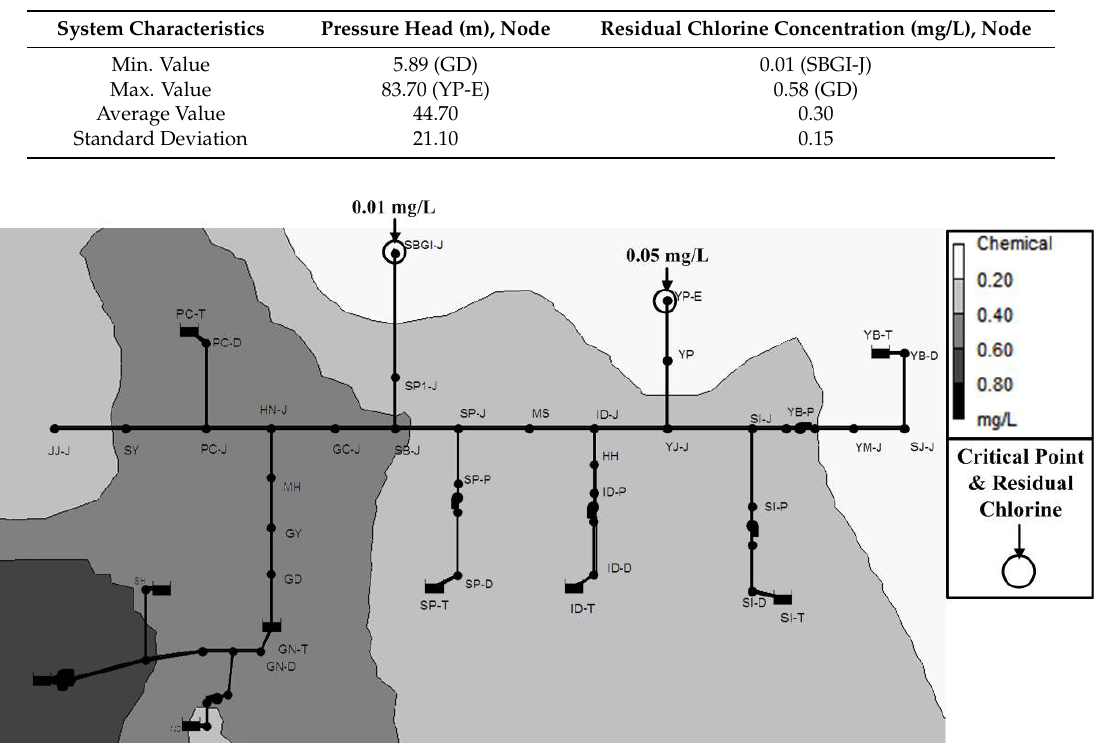
Table 1. Hydraulic and water quality simulation results for future conditions in the P-city network.